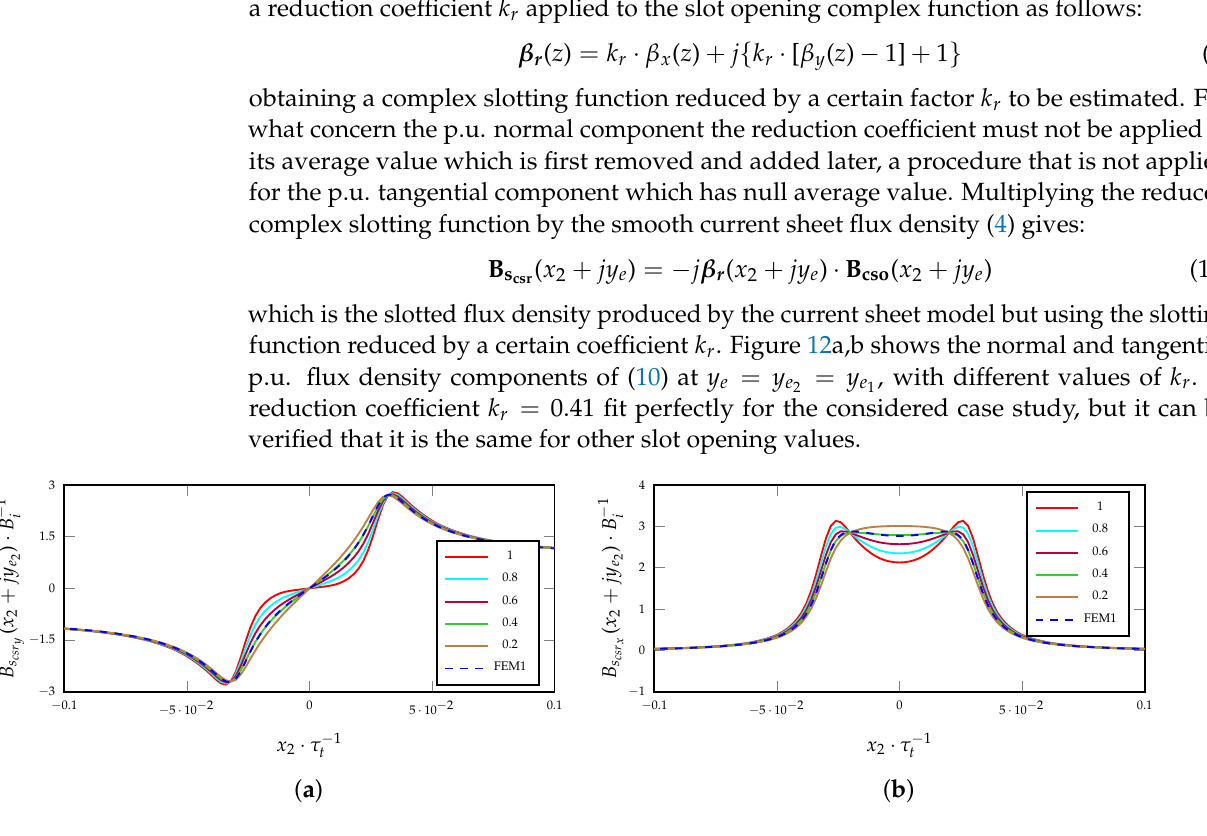
with different 2